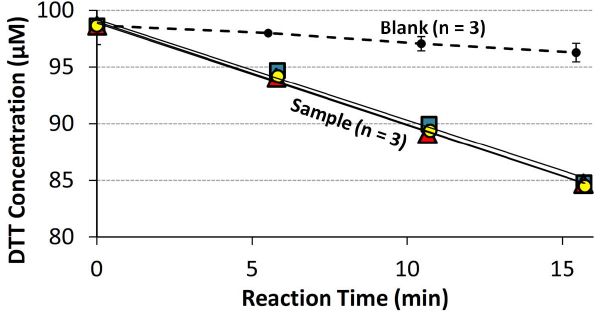
Fig. 2. Example of raw DTT data. Each sample initially contains 100µM of DTT with 0.050µM of PQN, while the blank initially contains 100µM DTT with no PQN. The rate of DTT loss for each sample vial is determined as the slope of its sample regression line (the three lines are shown, but are hard to distinguish because of their similarities) minus the daily blank slope. The blank slope is determined from the average ( ± 1 σ ) linear regression from triplicate blank